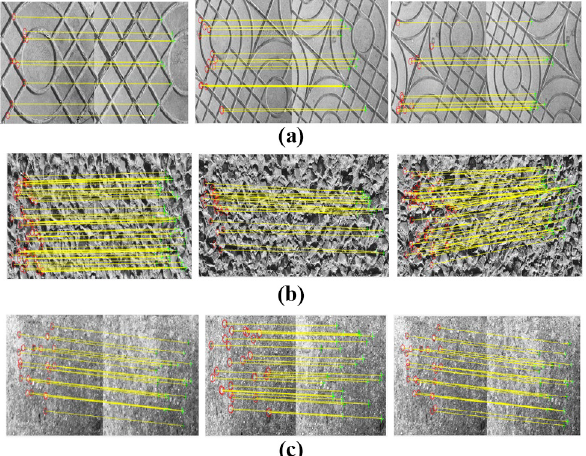
Figure 8 Surf algorithm matching results for three road surfaces